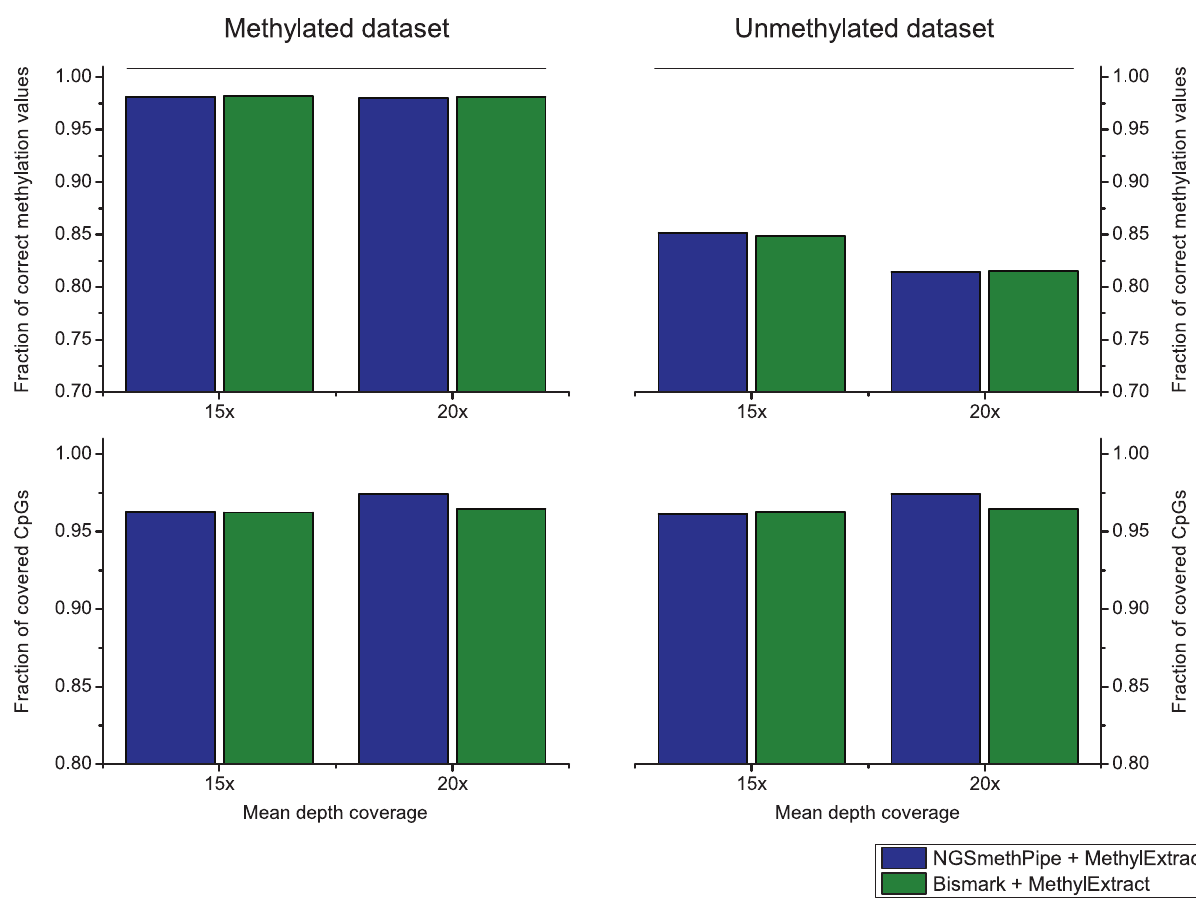
Figure 3. CpGs methylation profiling comparison for alignment methods. The results obtained from MethylExtract (correctly profiled methylation values and CpG coverage) using two bisulfite short read aligners, NGSmethPipe and Bismark are compared. The results are nearly independent of the used alignment